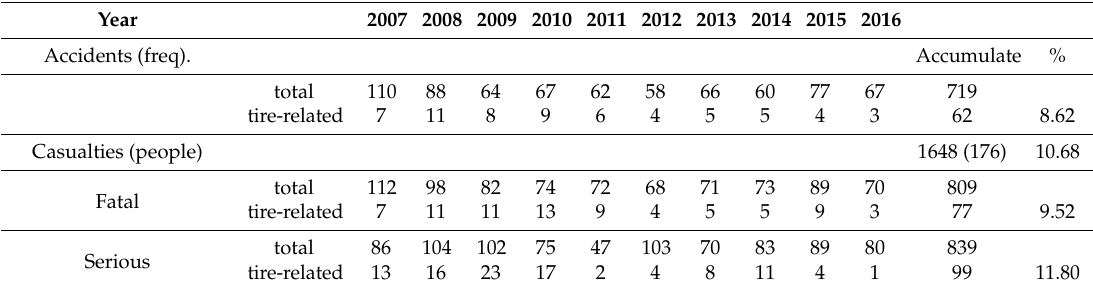
Table 1. Injury accidents and casualties involving tire-related factors, 2007–2016,